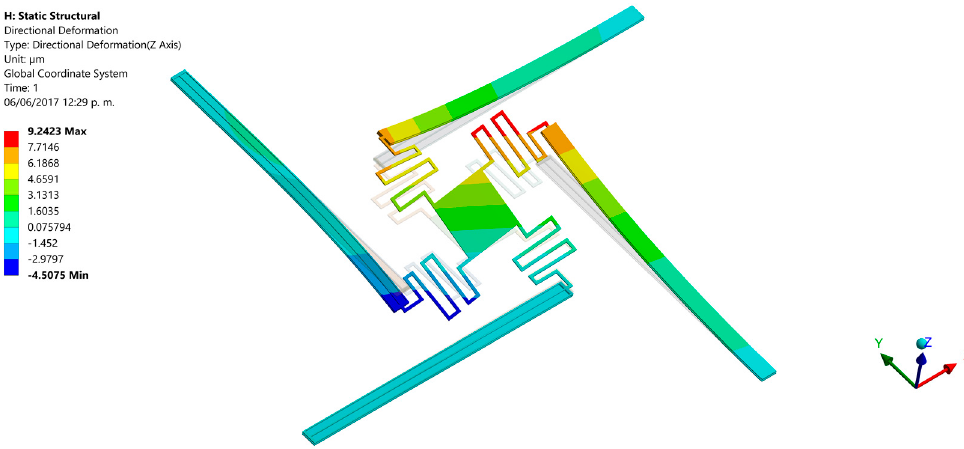
Figure 15. Out-of-plane displacements of the MEMS mirror when three polysilicon electrothermal actuators ( L h = L c = 550 μ m ) are biased with 2.5 V.